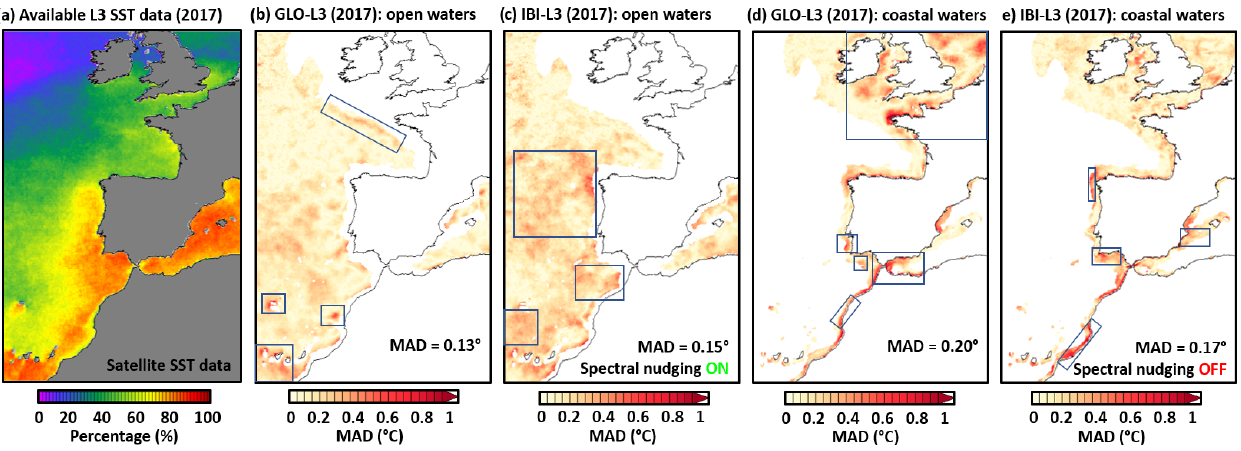
Figure 2. (a) Availability of satellite-derived L3 SST daily data for 2017; (b, c) annual mean absolute difference (MAD) of SST for 2017 in open water where the spectral nudging is applied: GLOBAL versus satellite and IBI versus satellite; (d, e) Analogous to (b, c) but in coastal waters where no spectral nudging is applied. Zones of worse model performance (i.e. higher MAD) are delimited with blue rectangles. Spatially averaged MAD values are provided in the lower-right